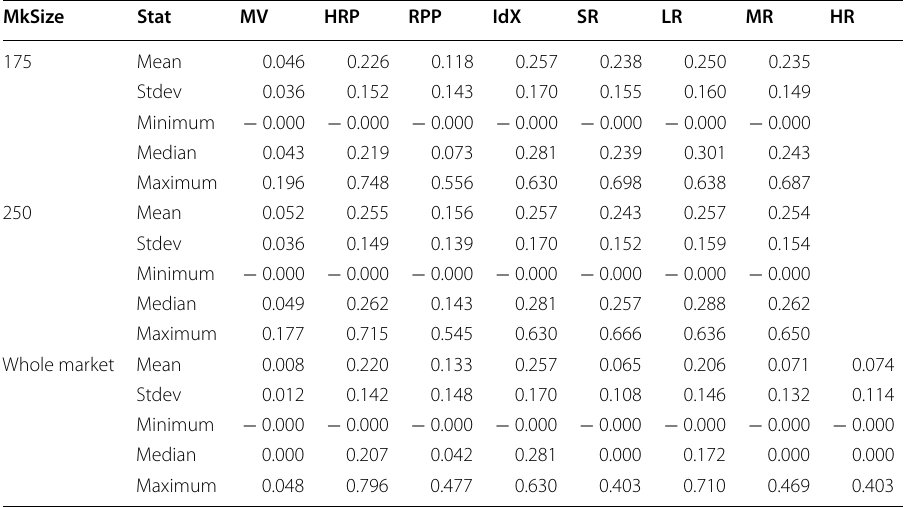
Table 6 Maximum Drawdown ( D max ) of the simulations (1500 random investing paths) for the different strategies MkSize